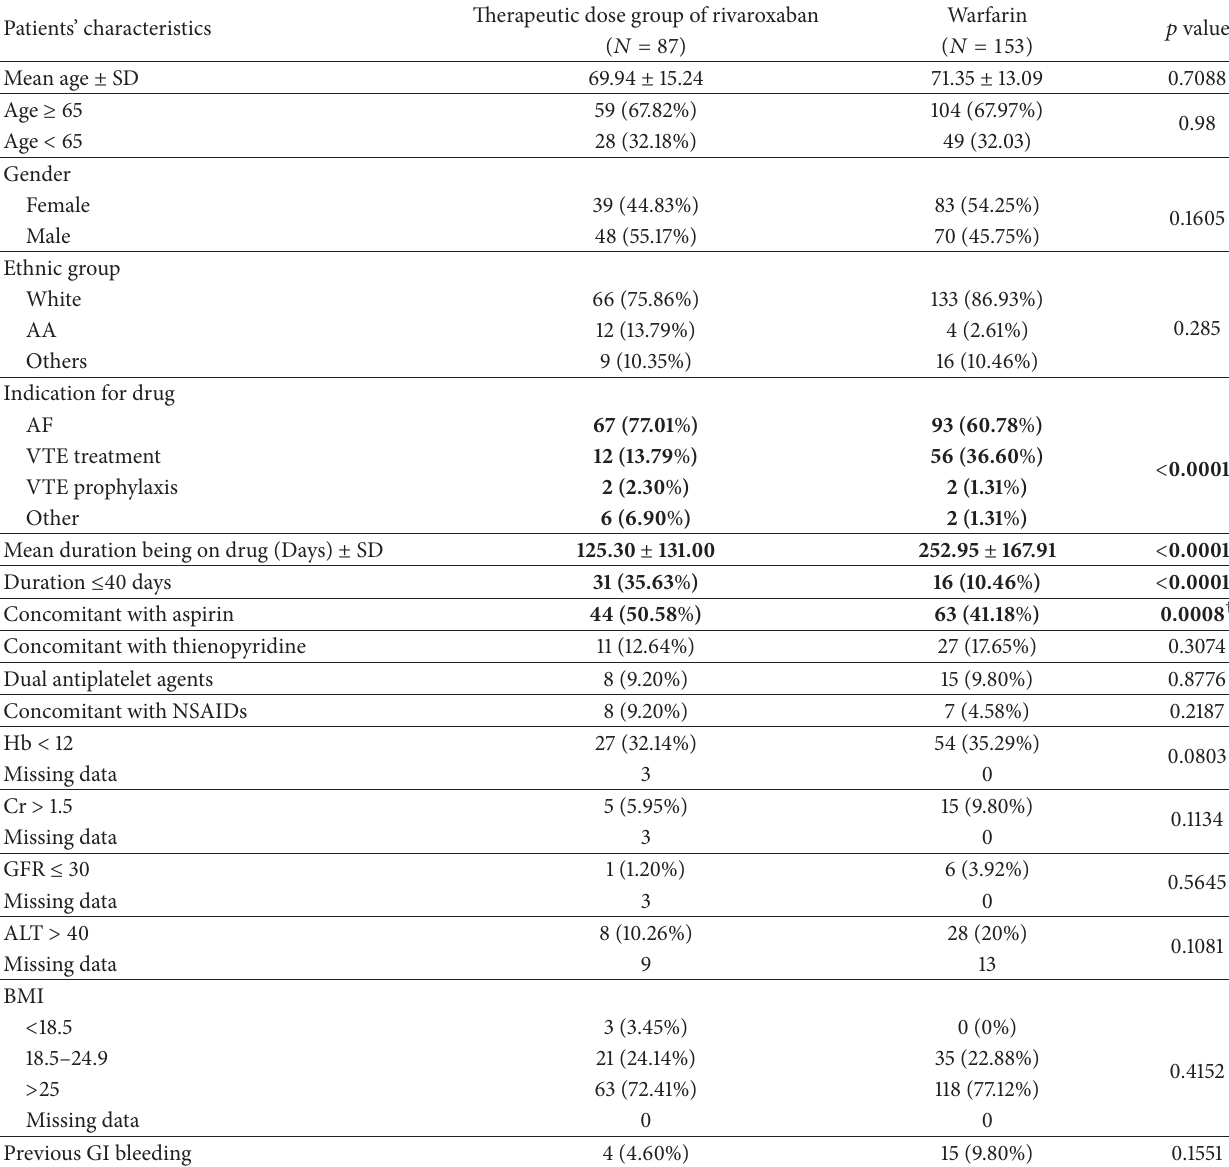
Table 2: Demographic and clinical characteristics of patients of therapeutic dose group of rivaroxaban compared to warfarin. Patients’